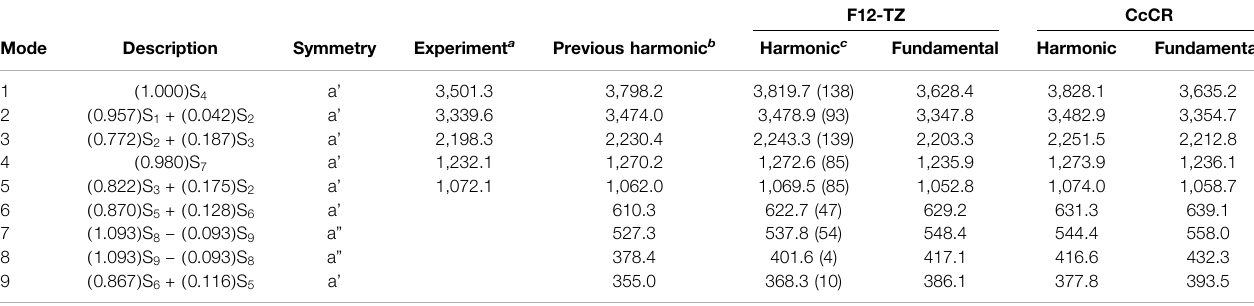
TABLE 3 | Vibrational frequencies (in cm − 1 ) of